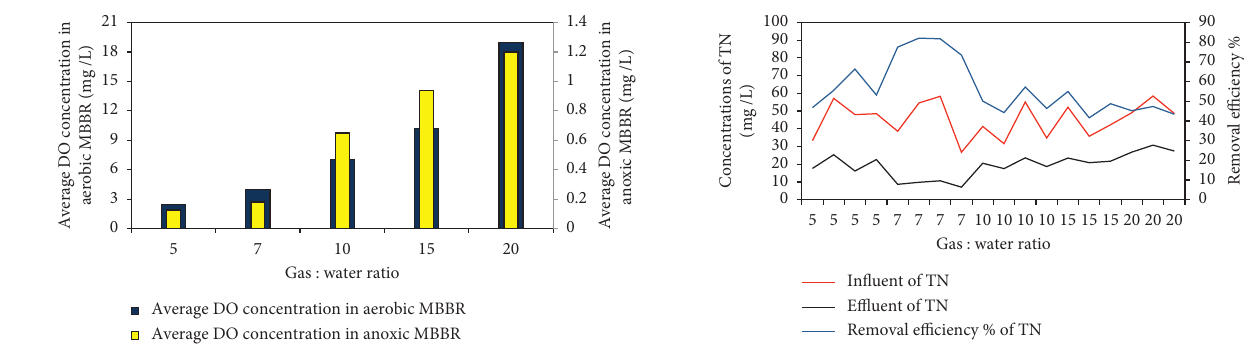
Figure 2: The average concentration of DO in A/O MBBRs system under different gas: water ratios.